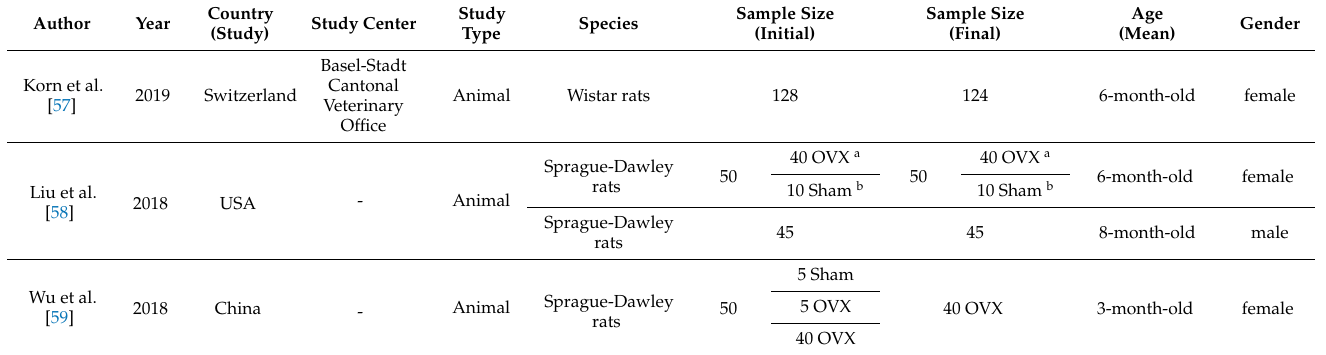
Table 1. Main characteristics of selected articles—part I.